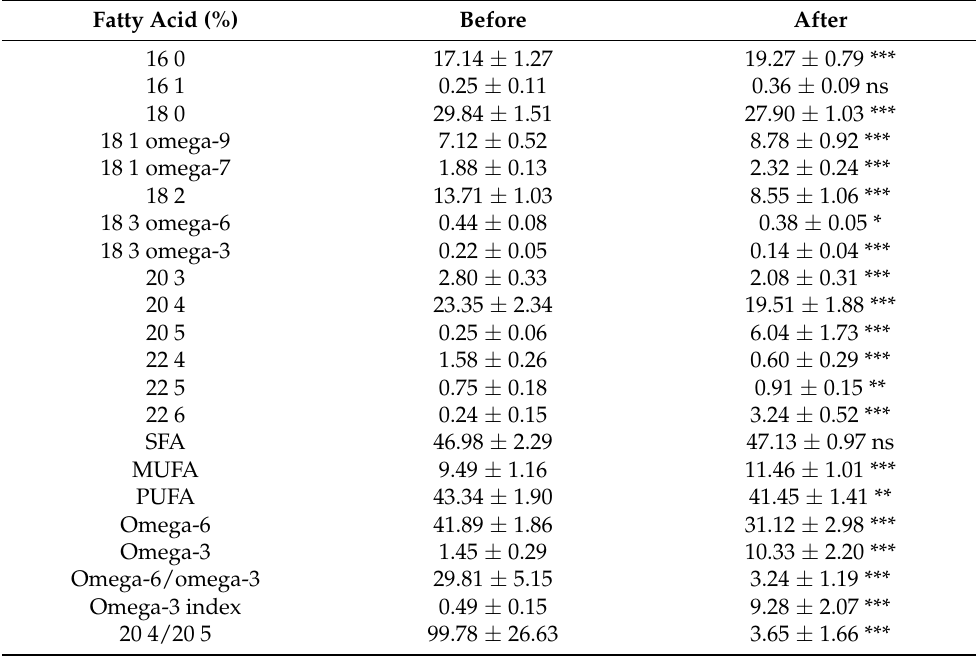
Table 4. Fatty acid profiles in erytrocyte phospholipids before and after treatment. Fatty Acid (%) Before After